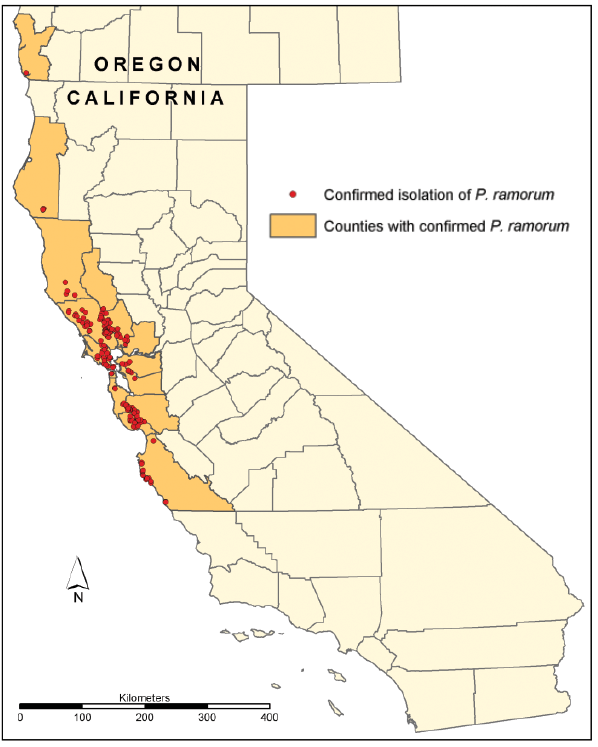
Fig. 4. Distribution of confirmed cases of Phytophthora ramorum in forests of California and Oregon in Janu- ary 2005. (Courtesy of M. Kelly, U.C. Berkeley, CA,